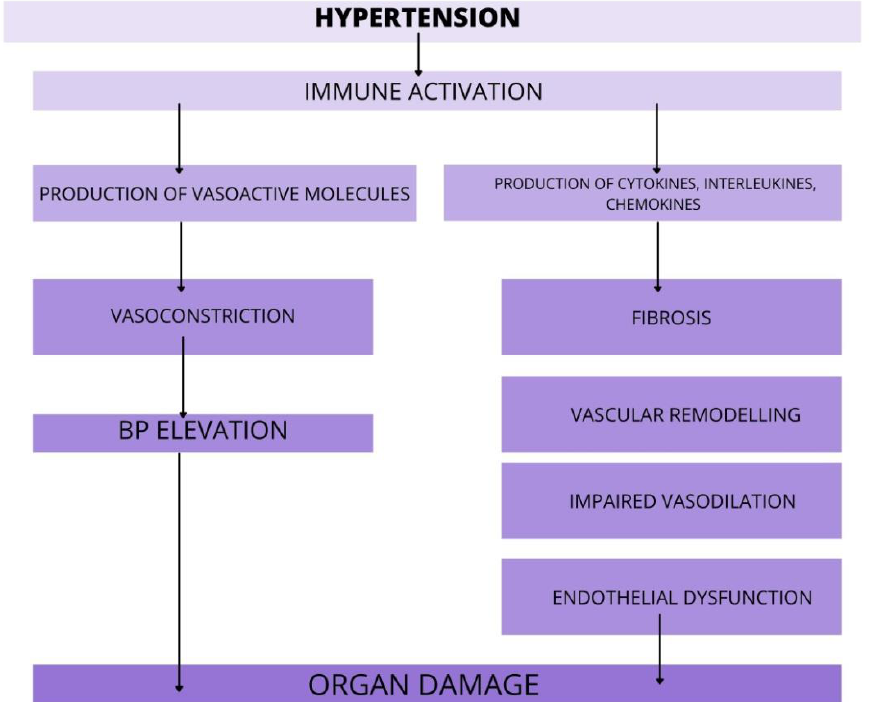
Figure 2. The role of immune cells in target organ damage. In response to hypertensive stimuli, the immune system is activated. Various immune cell subsets release pro-hypertensive molecules that promote organ damage via action in vasculature, kidneys, heart, and brain. Furthermore, the immune cells rise the BP via enhanced vasoconstriction and by that, worsen the course of AH. Abbreviations: BP-blood pressure, AH—arterial hypertension.